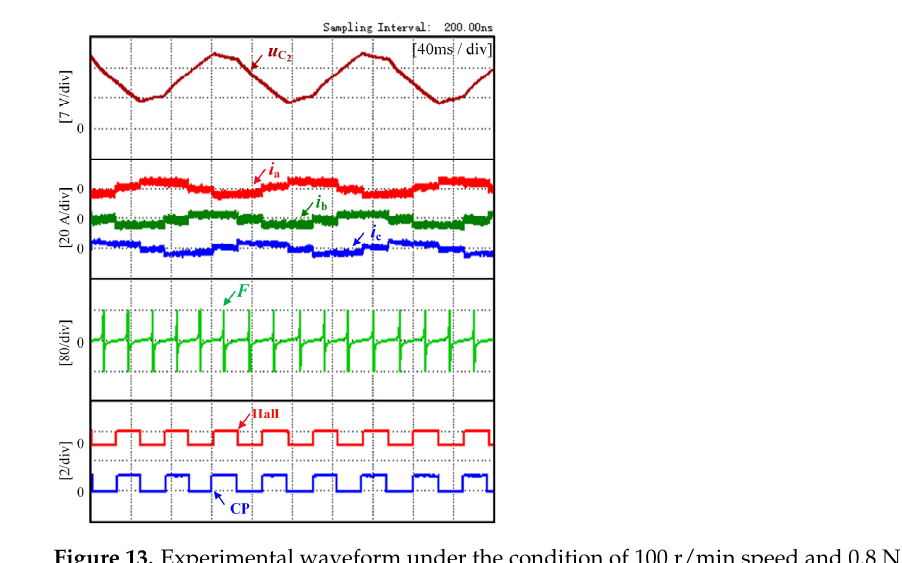
Figure 12. Experimental waveform under the condition of 200 r/min speed and 1 N·m torque.